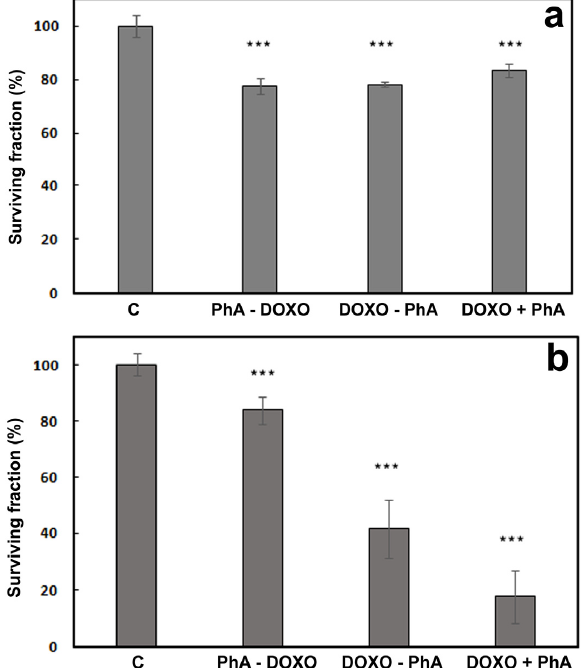
Figure 13. Viability of HeLa cells treated with DOXO 0.2 μ M and PhA 2 μ M according to three different protocols. Samples were either kept in the dark ( a ) or irradiated for 15 min after